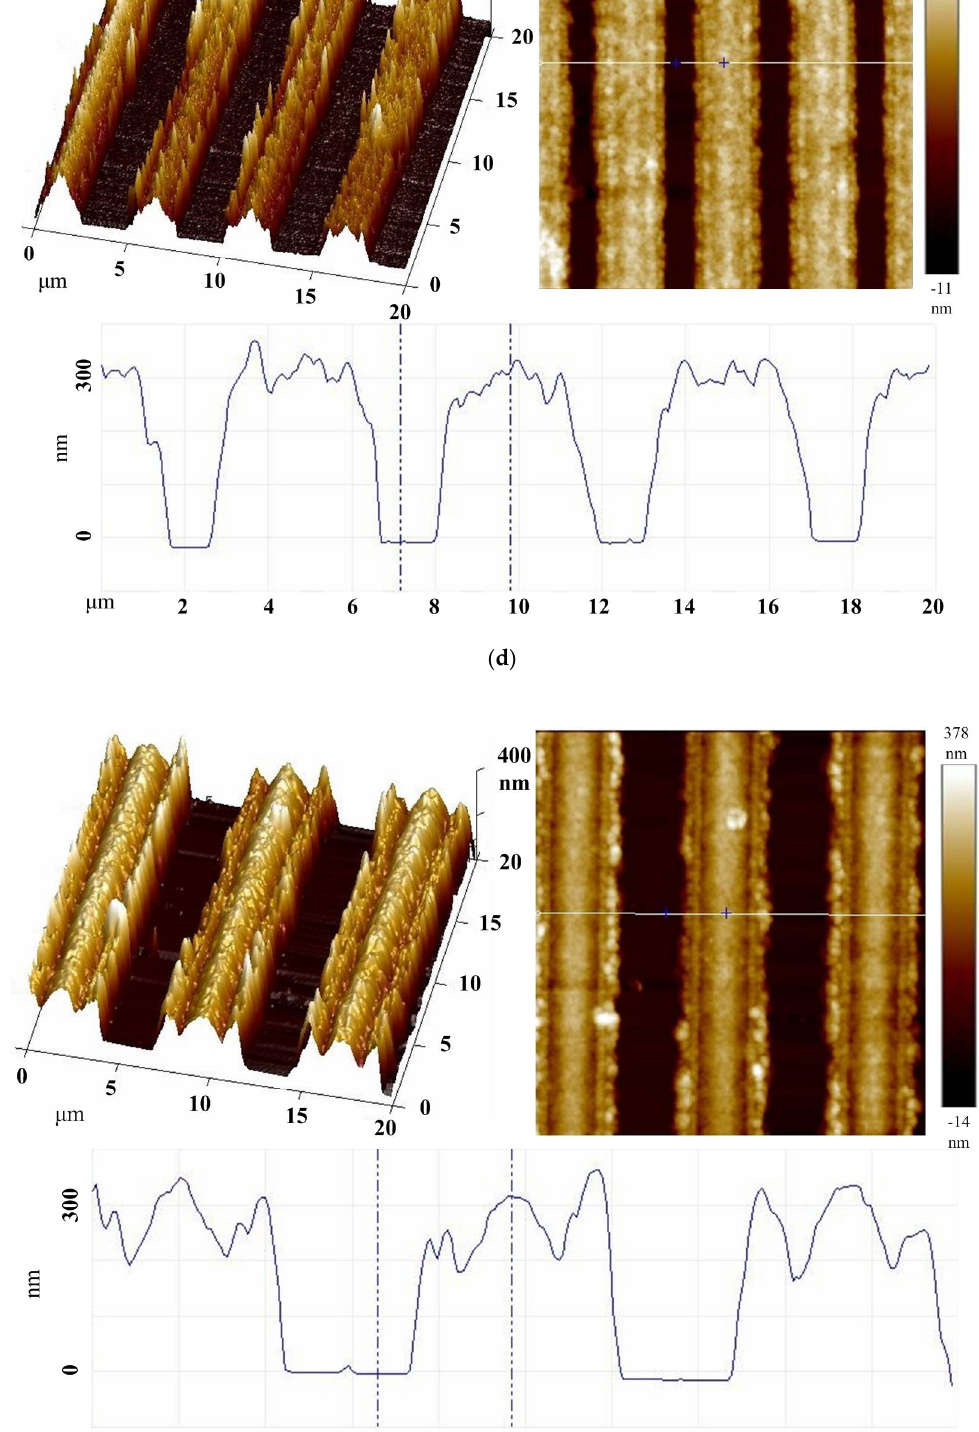
Figure 3. 2D and 3D AFM height images (20 µ m × 20 µ m) of ( a ) PG1, ( b ) PG1.5, ( c ) PG2 and ( d ) PG3, respectively.